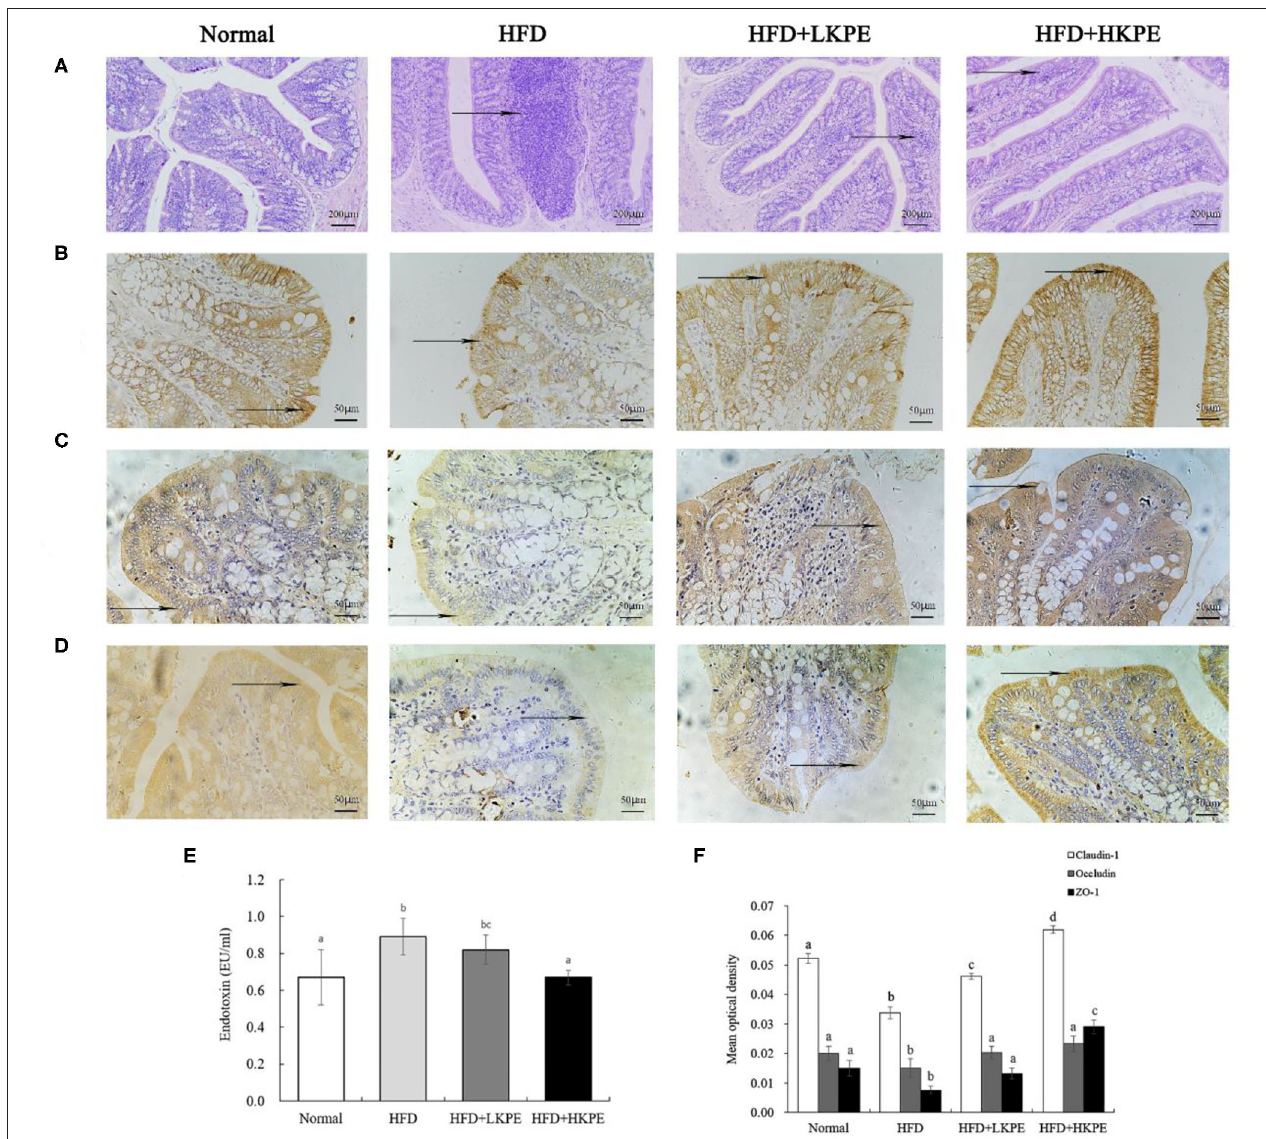
FIGURE 1 | KPE supplementation alleviates high fat diet induced intestinal barrier injury. (A) Photomicrographs in the colon of the rat (HE × 200); (B) Immunohistochemical images of Claudin-1; (C) Immunohistochemical images of Occludin; (D) Immunohistochemical images of ZO-1; (E) The content of serum endotoxin; (F) Mean optical density of Claudin-1, Occludin and ZO-1. Different letters (a–d) are used to express the significant difference ( p < 0.05) of the same factor among